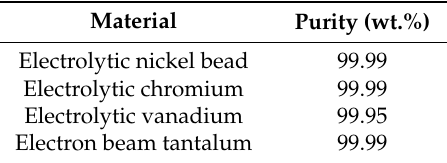
Table 1. Purity of raw materials.